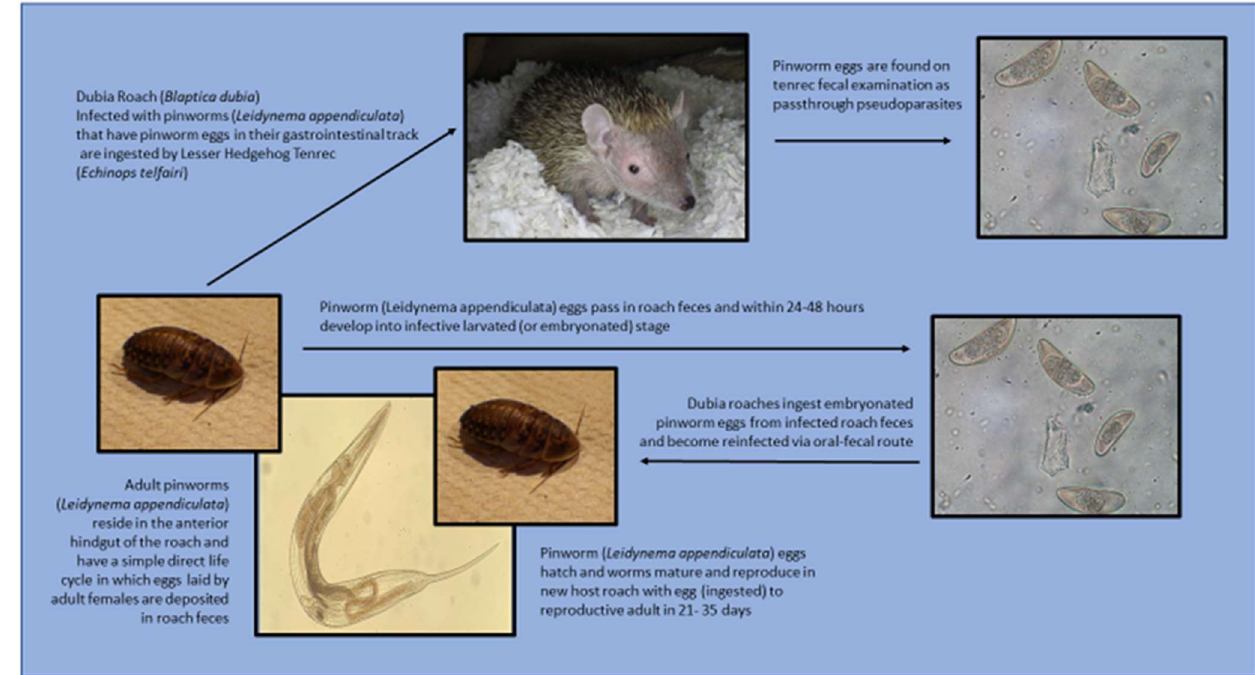
Figure 1. Transmission cycle of Leidynema appendiculata through the dubia roach ( Blaptica dubia ) host and lesser hedgehog tenrec ( Echinops telfairi ) as a passthrough pseudoparasite.